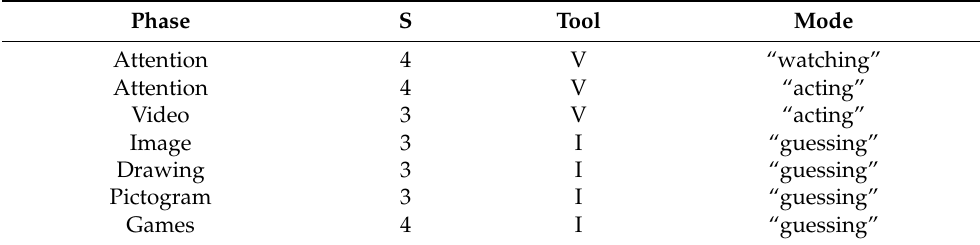
Table 5. Intervention sessions in [36]. S = Number of sessions, V-video,